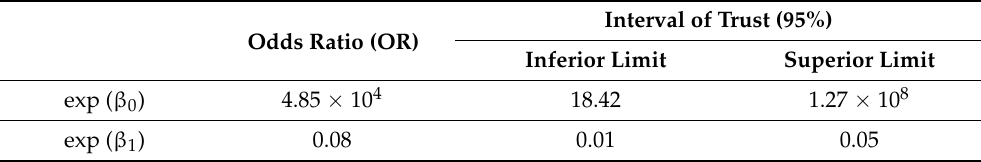
Table 10. Exponential of the estimate (odds ratio (OR)) of the parameters of the fitted model. Interval of Trust Odds Ratio (OR)